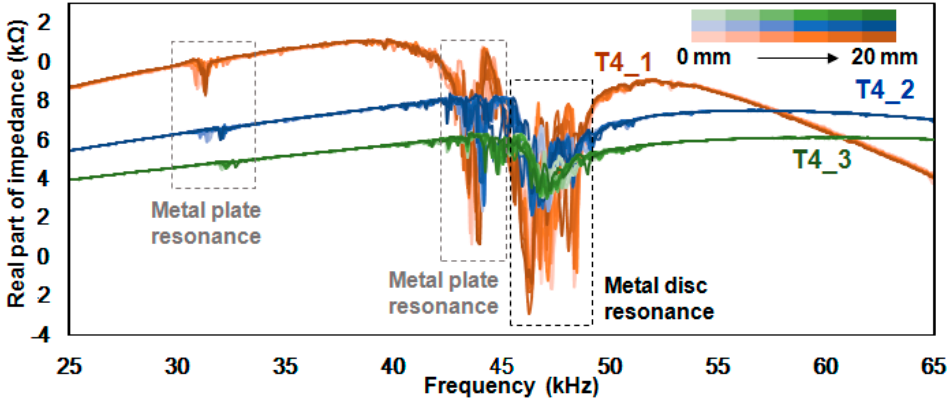
Figure 7. Impedance signatures for the T4_1, T4_2 and T4_3 experiment.